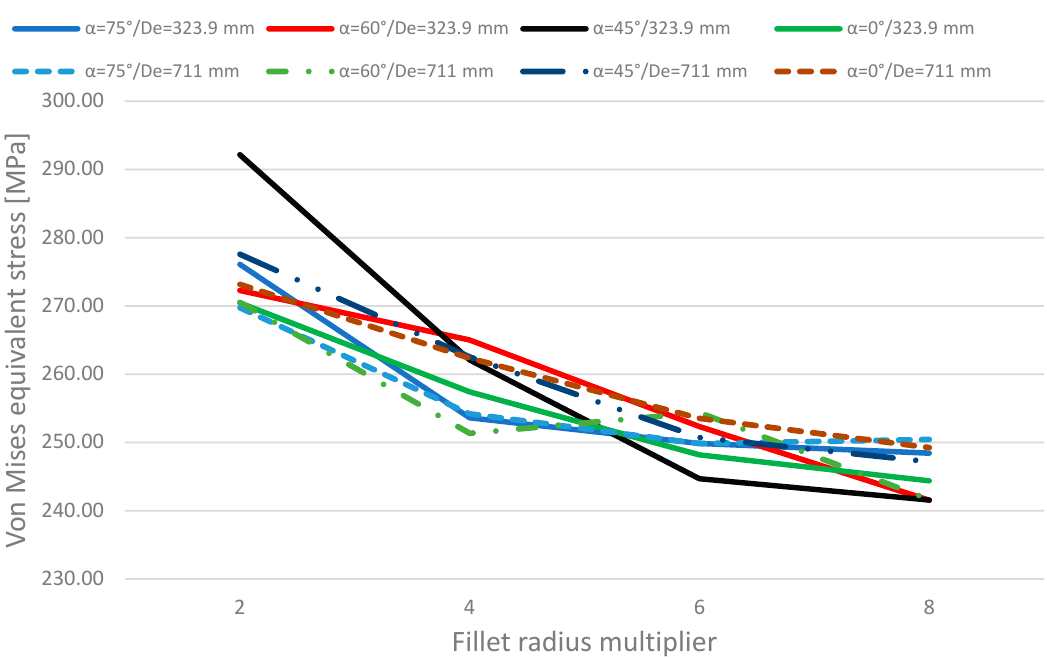
Figure 11. Von Mises equivalent stress evolution for several fillet radius multiplier values and defect orientations, for 323.9 mm and 711 mm steel pipes, type III composite, d rd = 0.3.